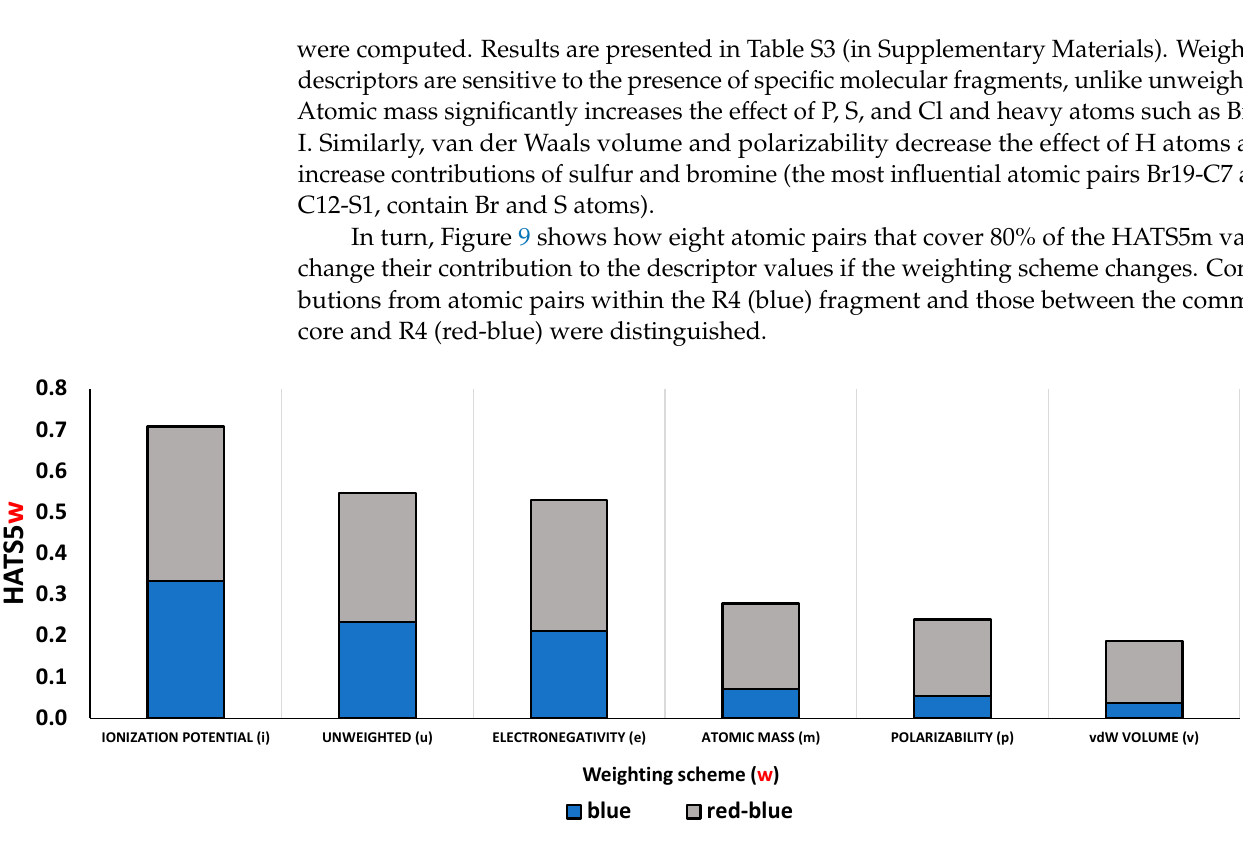
Figure 9. Contributions from atomic pairs within the R4 (blue) fragment and between the common core and R4 (red-blue) to the HATS5 value for different atomic weighting.